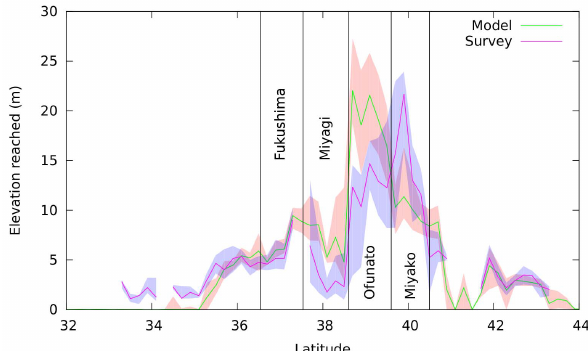
Fig. 16. Wave elevation reached as a function of latitude. For each dataset (modelled and surveyed) the curve is the median elevation in each 0.2 ◦ -wide bin, and the shaded areas delimit the lower and upper quartiles of the wave elevation distribution. The vertical lines indicate the different regions displayed in Fig.